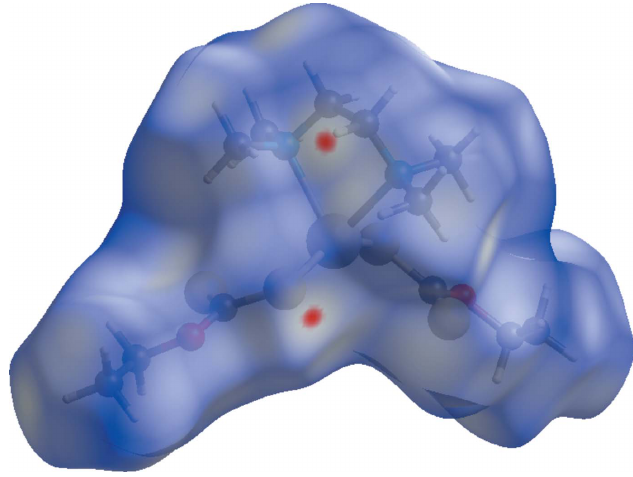
Figure 3 Hirshfeld surface mapped with d norm